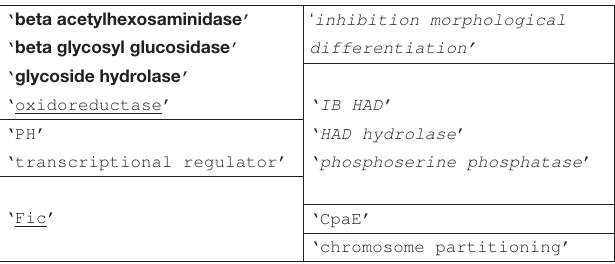
Mycobacteroides, Hoyosella, and Tsukamurella ( Table 1 ,